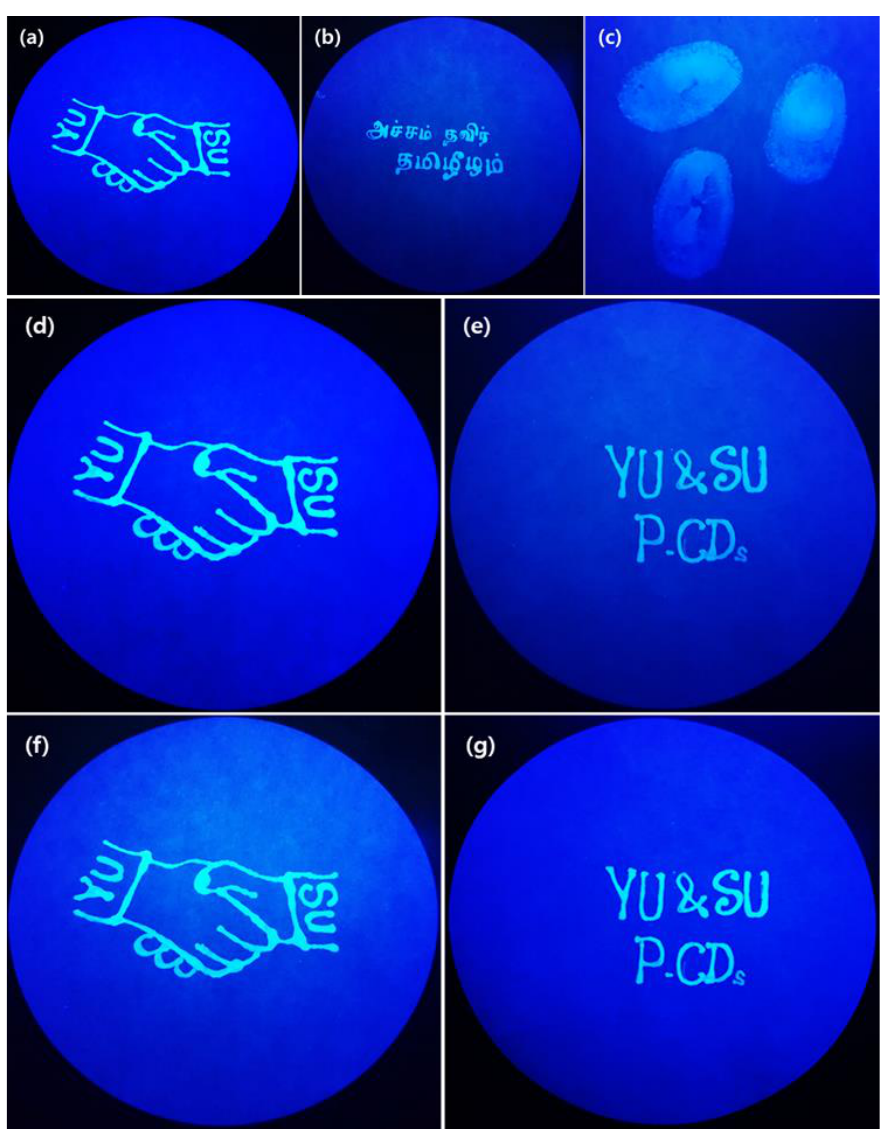
Figure 6. Digital photographic images of P-CDs ink-loaded commercial Whatman filter paper under 365 nm UV light; ( a ) hand-drawn pattern image, ( b ) handwritten words, and ( c ) P-CDs-formed fingerprints; ( d ) hand-drawn pattern and ( e ) handwritten letter images at the time of drawing/writing and the corresponding ( f ) hand-drawing pattern and ( g ) handwritten letter images after 4 months.